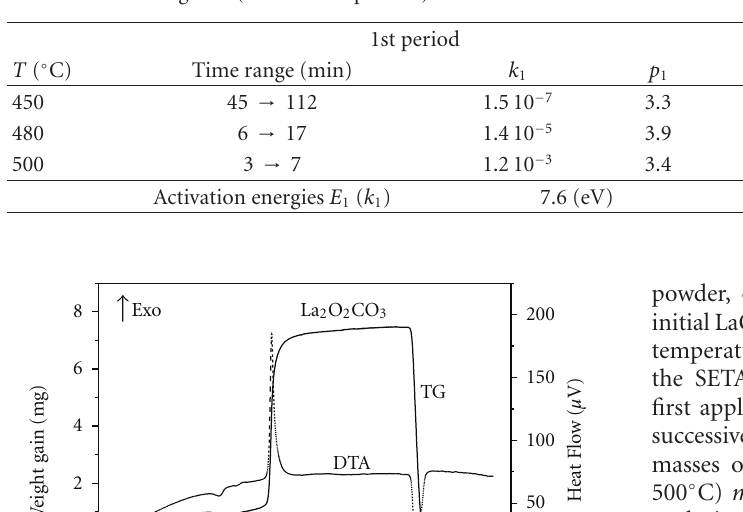
Table 1: Parameters extracted from Avrami’s model: k 1 and k 2 kinetics parameters and p 1 and p 2 exponents, respectively, associated with the fast and slow regimes (1st and 2nd periods).